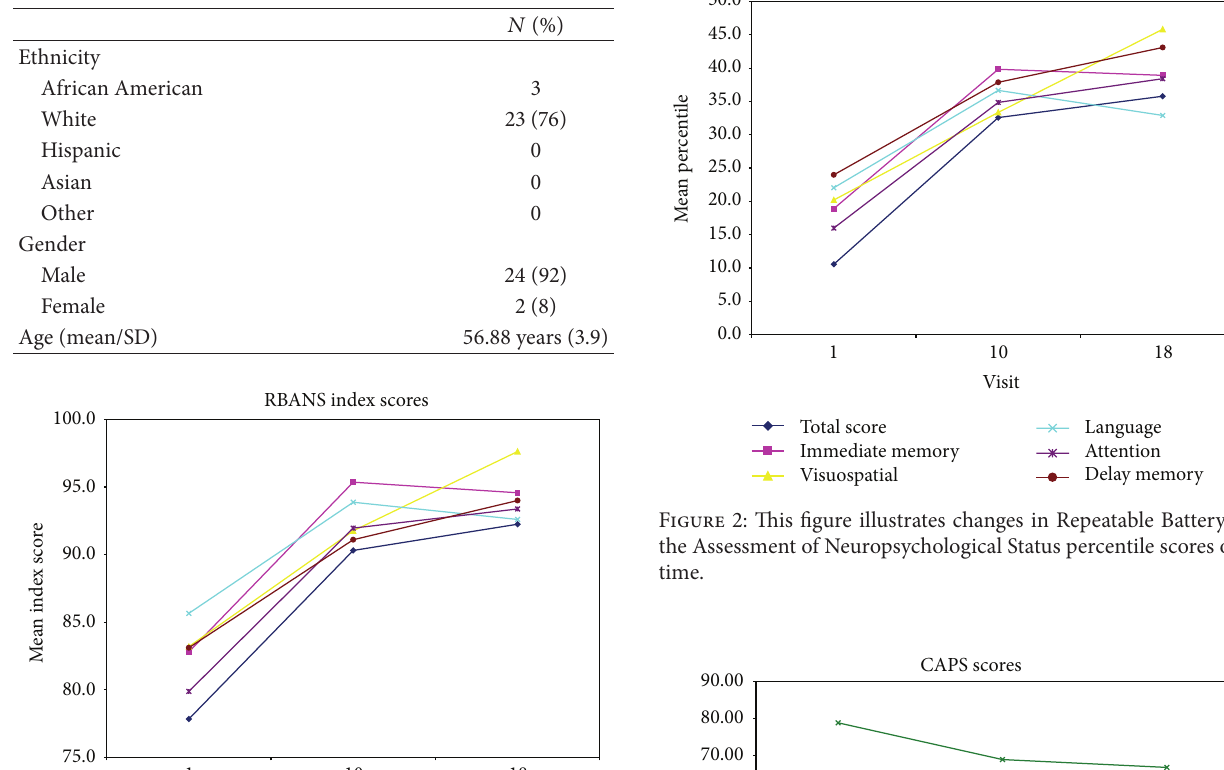
Table 1: Demographic and baseline characteristics.